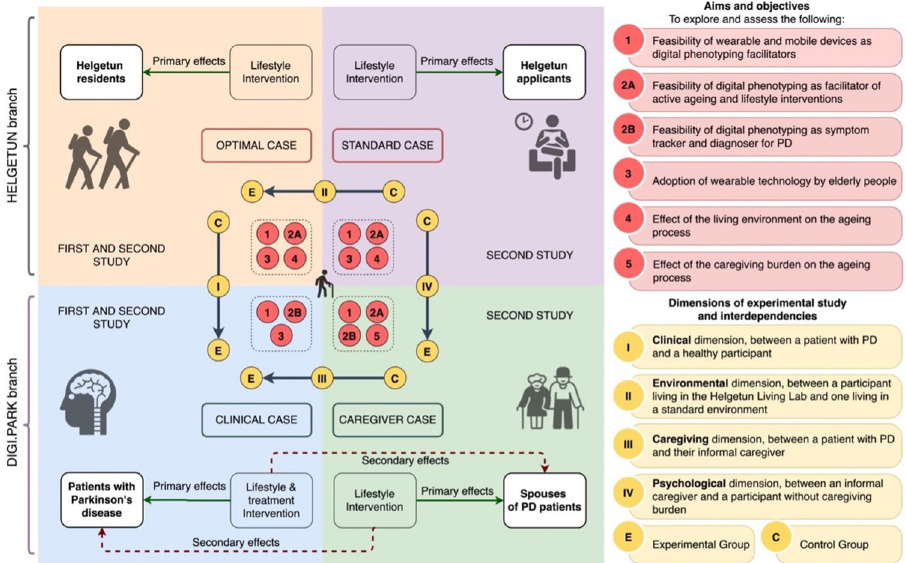
Fig 1. Participants in ActiveAgeing and their experimental features. I. Clinical dimension: Considering the participants with PD as the experimental group, and the participants in Helgetun as the control group, we explore the impact of a neurological condition (i.e., PD) on the ageing process. II. Environmental dimension: Considering the residents of Helgetun as the experimental group, and the people on the waiting list as the control group, we explore the impact of living in an innovative living environment like Helgetun on the ageing process. III. Caregiving dimension: Considering the participants with PD as the experimental group, and their informal caregivers as the control group, we explore the impact of a neurological condition (i.e., PD) on the ageing process in dyads of participants. IV. Psychological dimension: Considering the caregivers of people with PD as the experimental group, and the people on the waiting list for Helgetun as the control group, we explore the psychological impact of having caregiving duties on the ageing process.